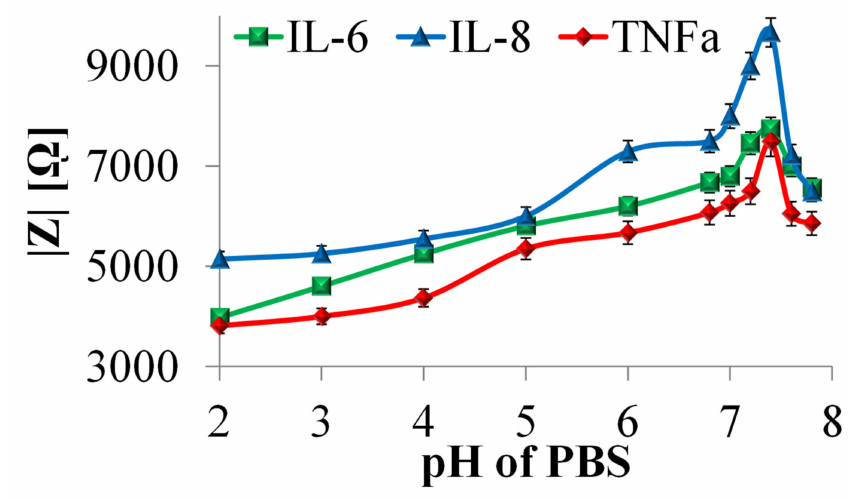
Figure 7. Influence of electrolyte pH on the value of the impedance modulus measured at the frequency of 0.1 Hz of the impedance biosensor IL-6, IL-8 and TNF α , recorded in a 0.01 M PBS solution, using the amplitude of the excitation signal of 10